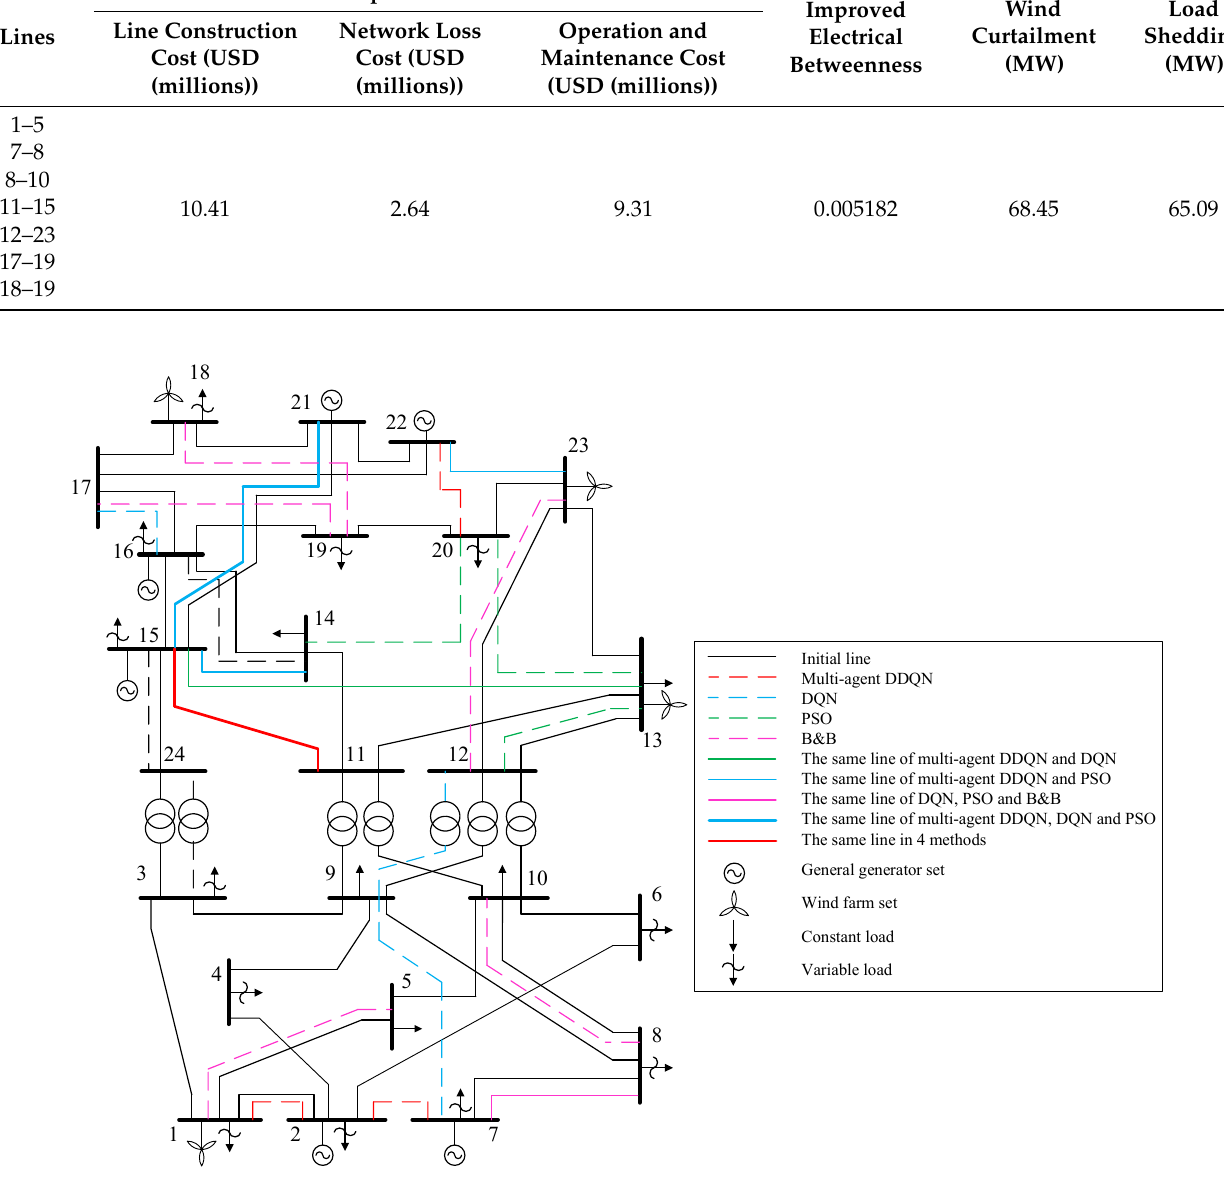
Figure 8. The transmission network structure of four methods in modified IEEE RTS 24-bus.